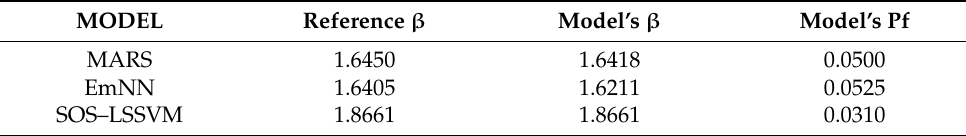
Table 2. Reliability index ( β ) of